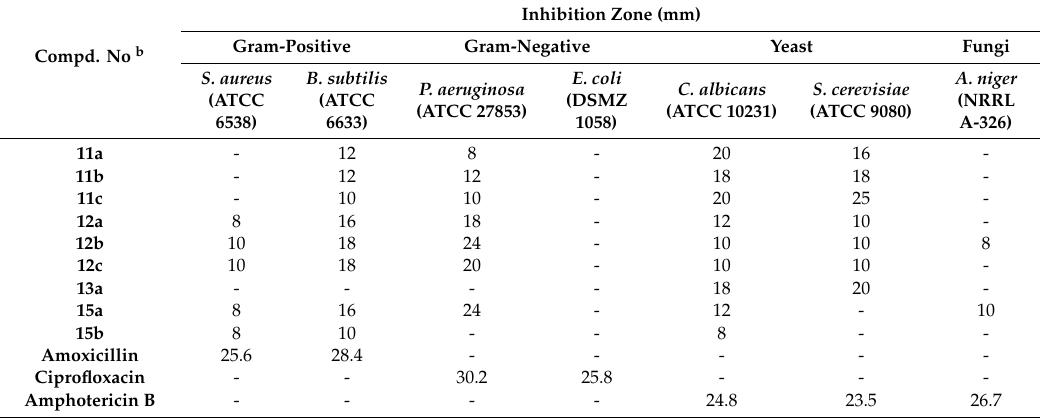
Table 1. Antimicrobial activity of the most active compounds (20 mg per disc). a.